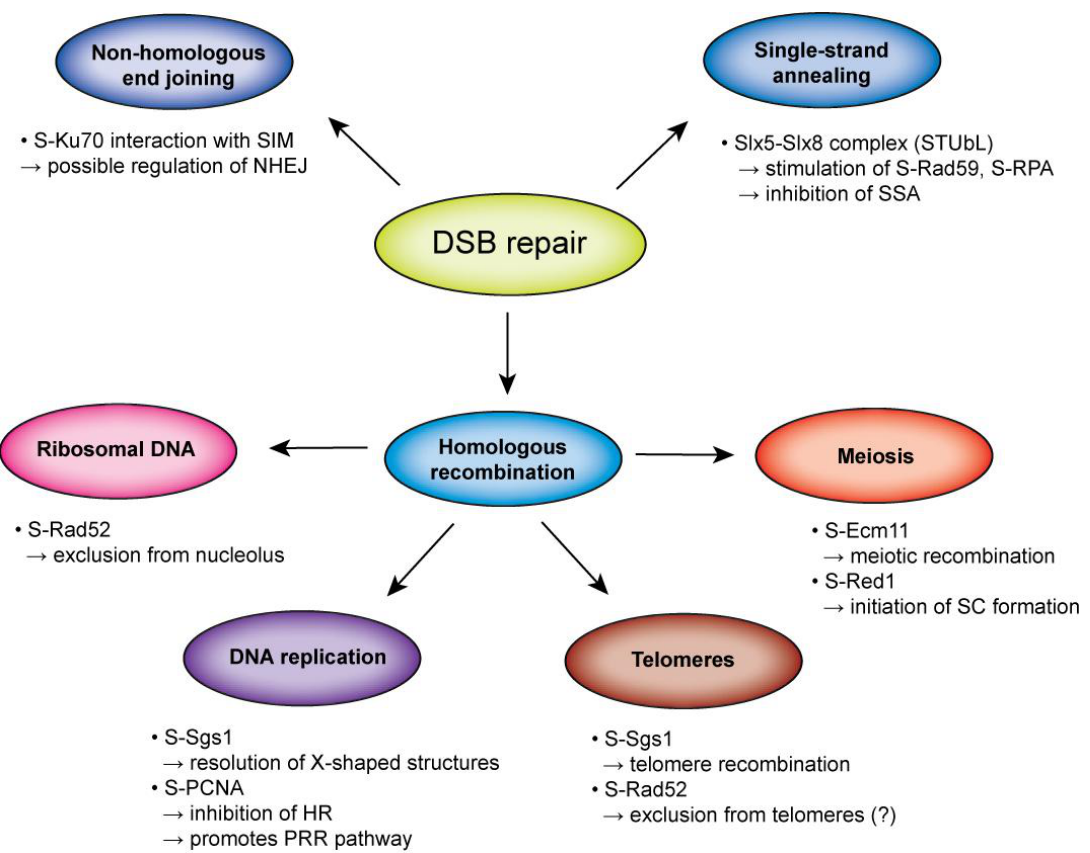
Figure 4. Role of sumoylation on the relationship of homologous recombination and other DNA metabolic processes in S. cerevisiae . Sumoylation influences not only repair of DSBs but also homeostasis of rDNA and telomeres, DNA replication, and meiosis. Examples of sumoylation’s involvement in this interplay are